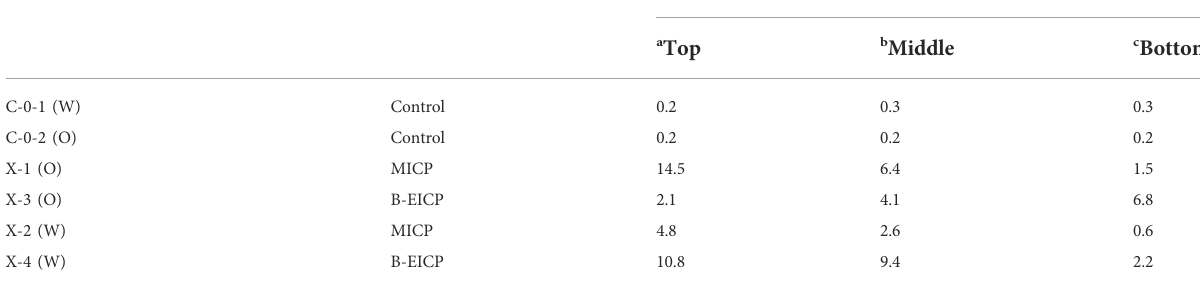
Representative samples collected from, a 1 cm depth measured from the specimen surface. b